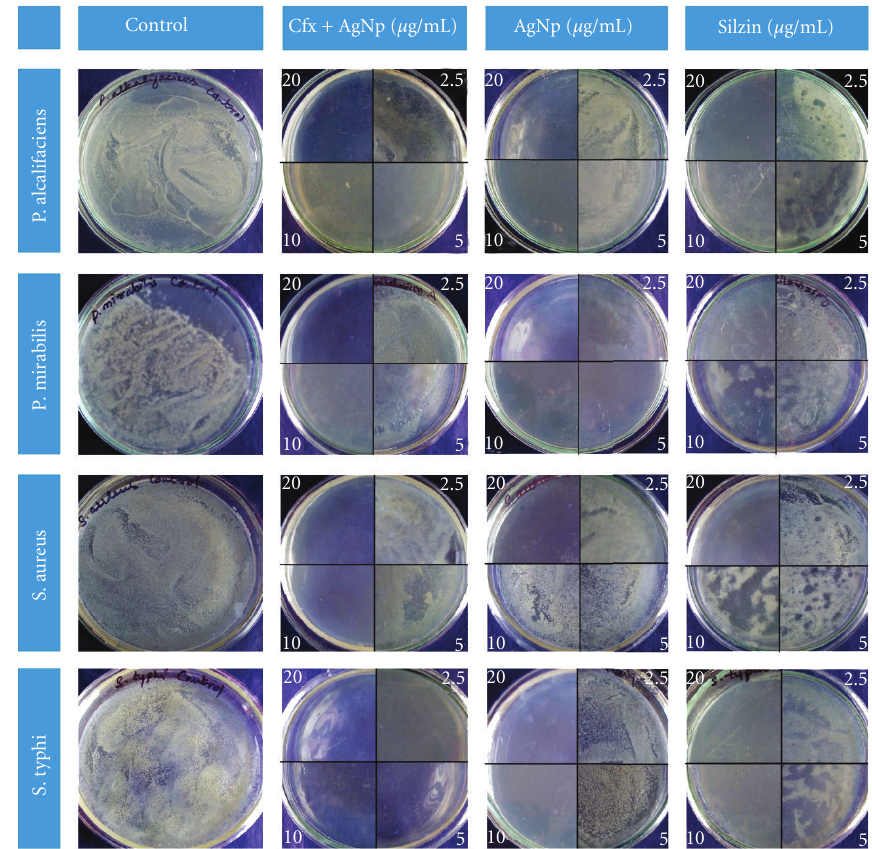
Figure 9: Antimicrobial activity of the AgNP using edible mushroom Pleurotus florida . E ff ects of AgNP with cefixime, AgNP, and the standard drug silver sulfadiazine (silzin) in di ff erent concentrations are shown in the figure.